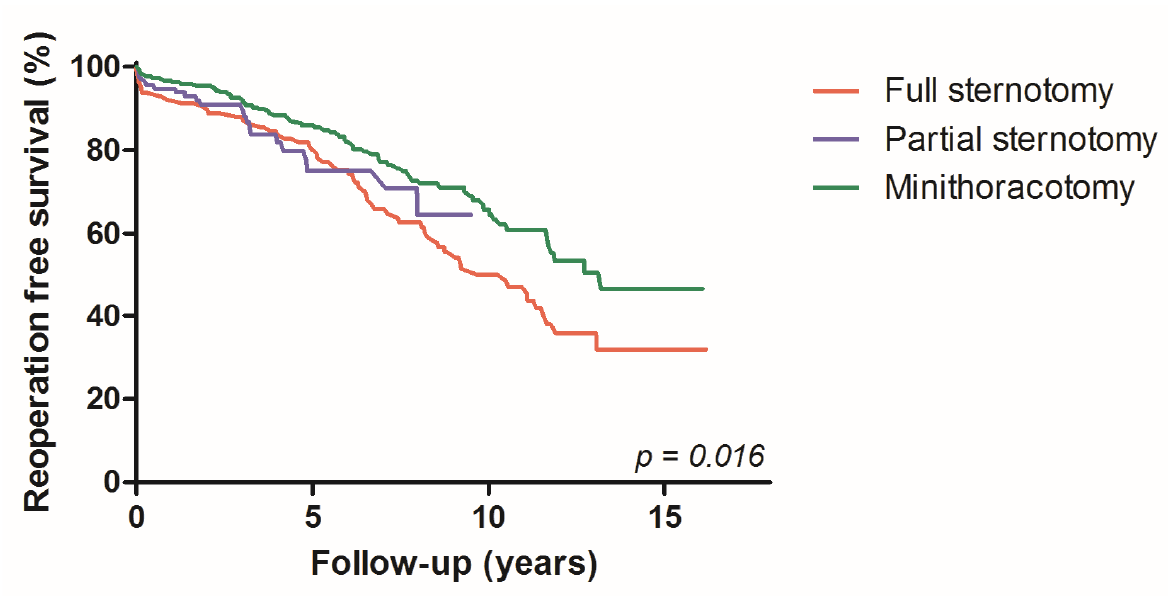
Figure 2. Kaplan-Meier curves: reoperation-free survival, according to the three access types.